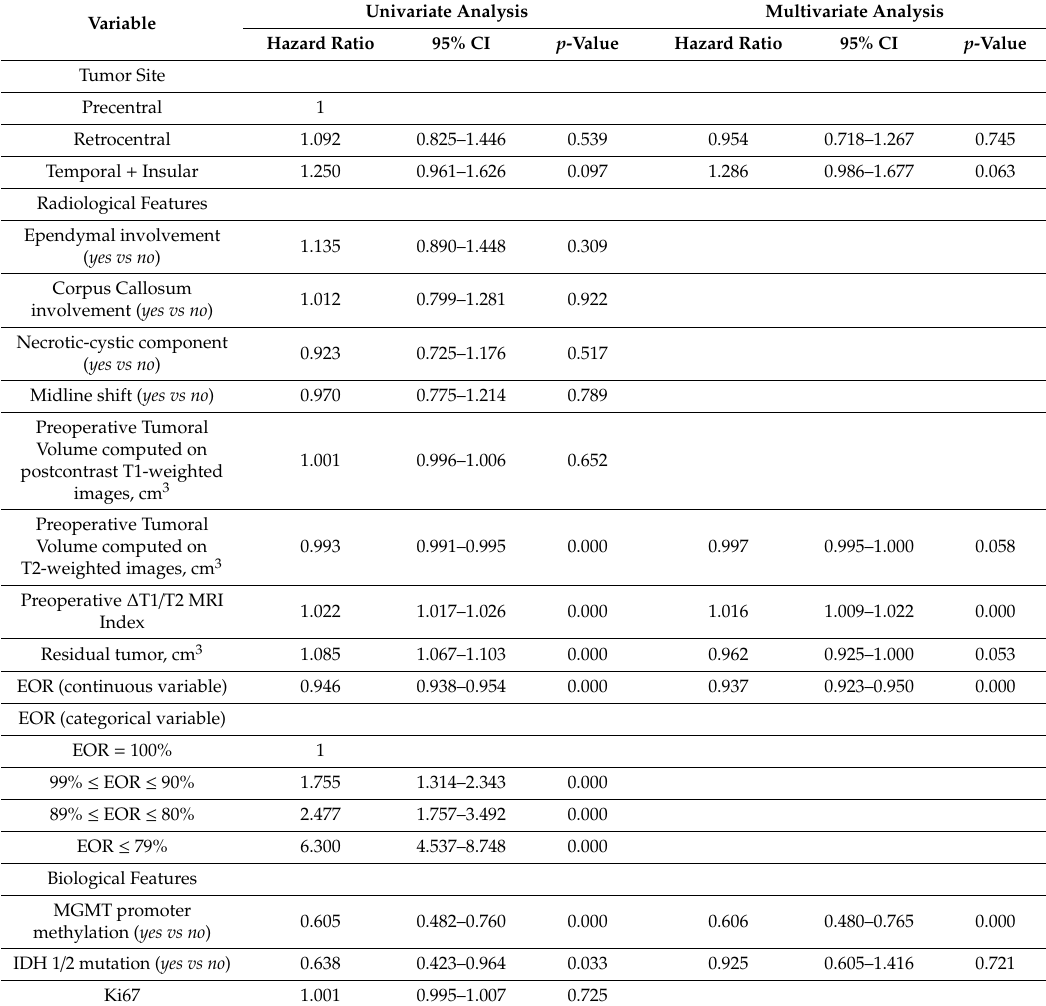
Table showing the influence of di ff erent factors on the OS rates as per univariate survival analysis and multivariate analysis on the entire GBM patients cohort. ( p -value < 0.05 at Log-rank test). Boldfacing values represent